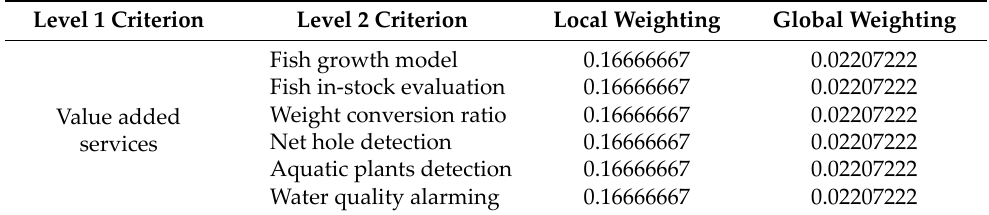
Table 13. Level 2 criteria priority evaluation results for Level 1 ‘value added services’ criterion using the modified